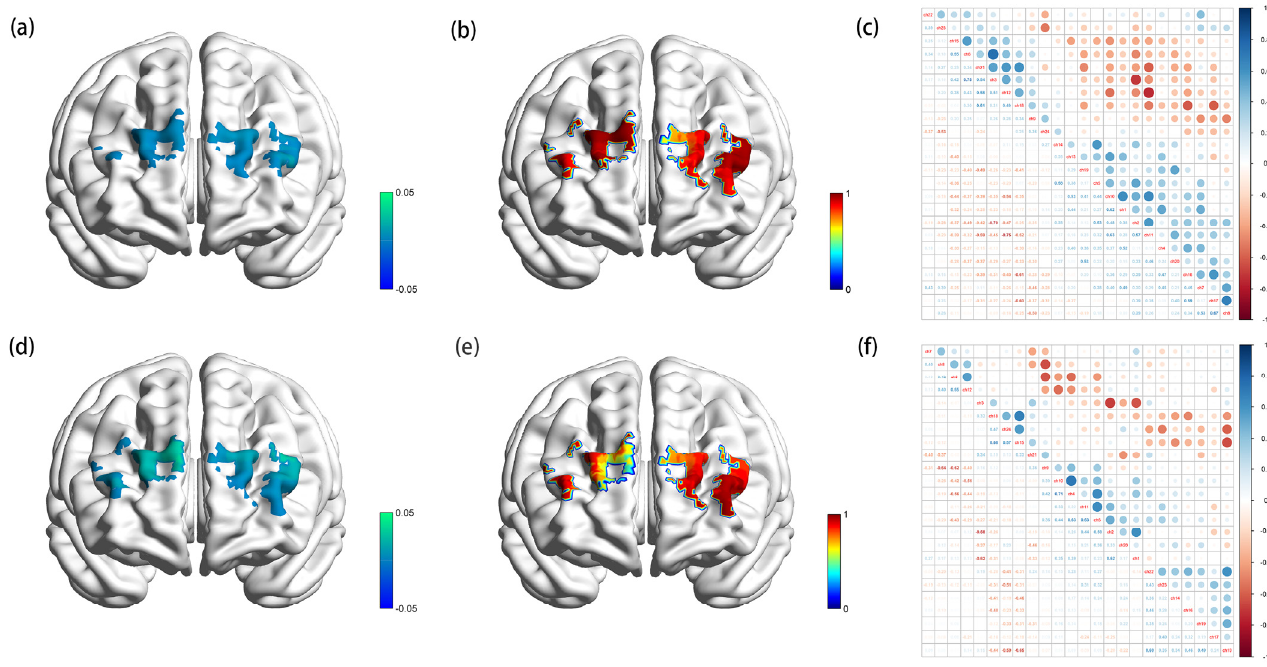
Figure 1. β -map reflected by oxygenated hemoglobin activation ( a ), p-map indicating the association between channel activation and accuracy ( b ), and Spearman correlation matrix of channel activation ( c ) of Stroop congruent test; β -map reflected by oxygenated hemoglobin activation ( d ), p-map indicating the association between channel activation and accuracy ( e ), and Spearman correlation matrix of channel activation ( f ) of Stroop incongruent test.